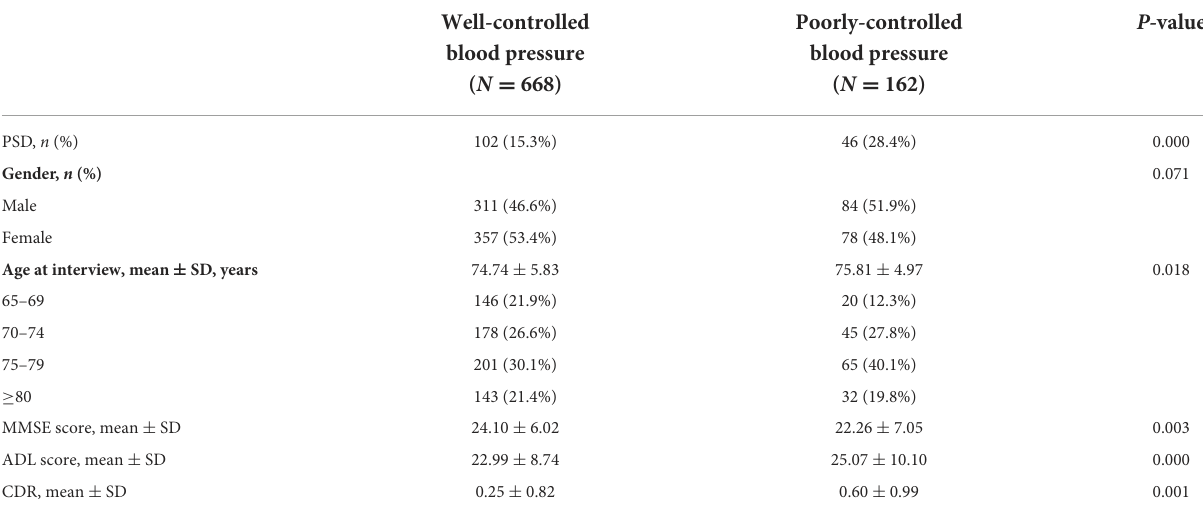
TABLE 2 Association of blood pressure control with PSD in stroke